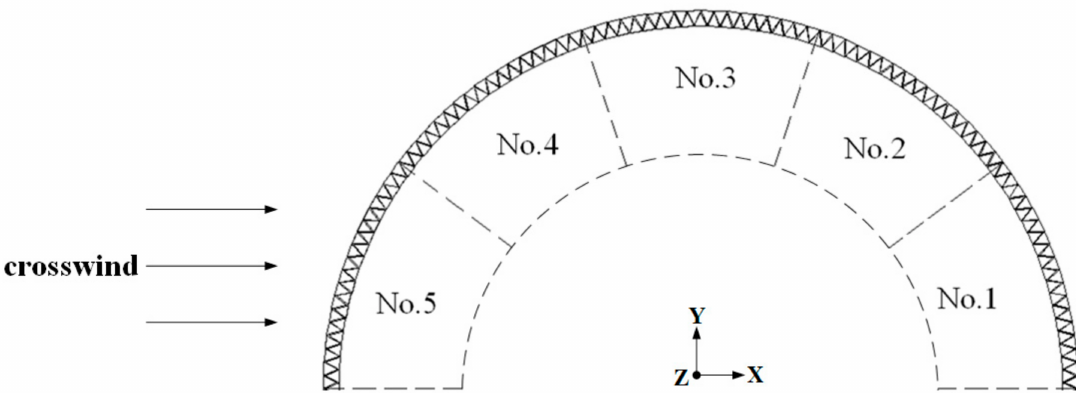
Figure 4. Sector